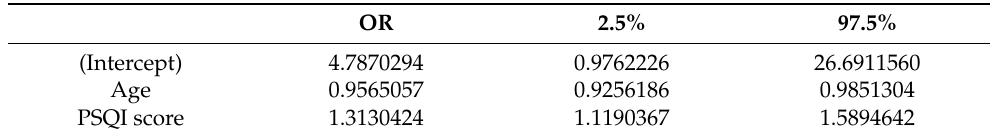
Table 7. Regression model evidencing the impact of age and PSQI score on the occurrence of nocturnal